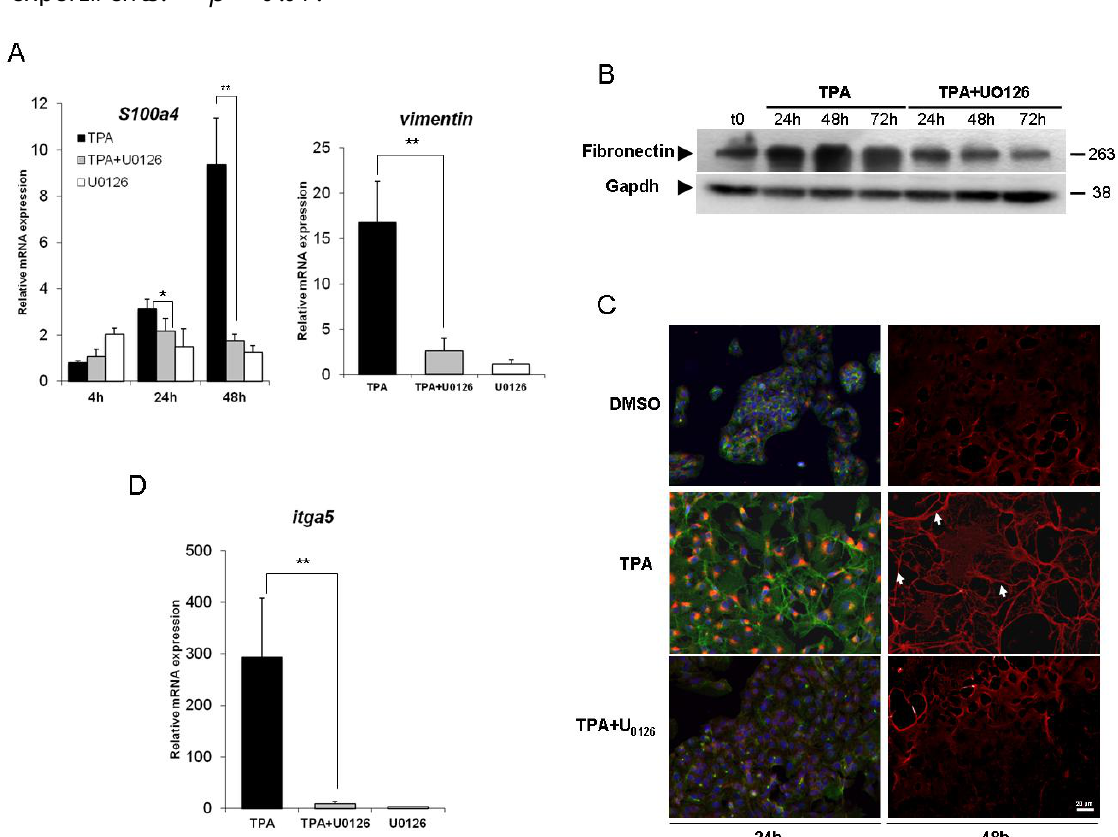
Figure 2. ERK1/2 inhibition reverses the epithelial to mesenchymal transition (EMT) process induced by TPA. ( A ) changes in mRNA levels for the EMT-related S100a4 and vimentin genes were assessed by real-time RT-PCR. The HepG2 cells were stimulated with 100 nM TPA, with or without U0126, for 4 h, 24 h and 48 h ( S100a4 ) or 48 h (v imentin ); ( B ) Cells were exposed to 100 nM TPA, with or without U0126, for 24 to 72 h. At the indicated times, cells were lysed and fibronectin protein levels were assessed by western blotting (results representative of three experiments); ( C ) HepG2 cells were grown on coverslips and treated with TPA with or without U0126 for 24 h (intracellular fibronectin) or 48 h (fibronectin deposition). After exposure, the cells were fixed and processed for indirect immunofluorescence analysis for the detection of fibronectin (red) and visualization of the actin cytoskeleton (phalloidin, green) and nuclei (DAPI, blue). The results shown are representative of three independent experiments; ( D ) itga5 mRNA levels were assessed by real-time RT-PCR after 48 h of TPA treatment, with or without U0126. For all real-time RT-PCR experiments ( A and D ), relative mRNA levels with respect to gapdh mRNA levels are given, and the mRNA levels in DMSO-treated cells are taken as 1. Errors bars indicate the mean ± SEM of triplicate determinations in three independent experiments. ** p <